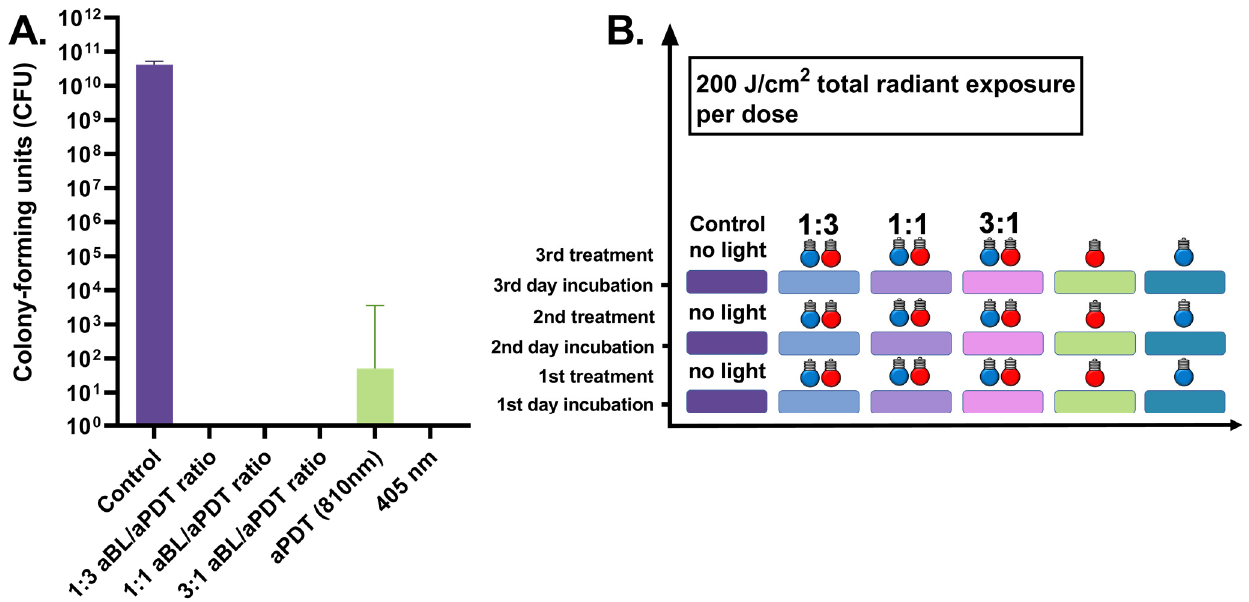
Figure 6. ( A ). Effects of different irradiance ratios of aBL and aPDT in the dual-light aPDT system in three-day S. aureus biofilm, when the antibacterial treatment is given once daily at 200 J/cm2. Three-day S. aureus biofilm, daily dose, aBL vs. dual-light 1:3 aBL/aPDT ratio, p = ns; aBL vs. dual-light 1:1 aBL/aPDT ratio, p = ns; aBL vs. dual-light 3:1 aBL/aPDT ratio, p = ns; aPDT vs. dual-light 1:3 aBL/aPDT ratio, p = ns; aPDT vs. dual-light 1:1 aBL/aPDT ratio, p = ns; aPDT vs. dual-light 3:1 aBL/aPDT ratio, p = ns; aBL vs. aPDT, p = ns; dual-light aPDT: 1:3 aBL/aPDT ratio vs. 1:1 aBL/aPDT ratio, p = ns; 1:3 aBL/aPDT ratio vs. 3:1 aBL/aPDT ratio, p = ns; 1:1 aBL/aPDT ratio vs. 3:1 aBL/aPDT ratio; p = ns. The y -axis displays the median of CFUs. Six assays were performed for each experiment, and the control biofilm was performed in three assays. The 95% confidence interval (CI) is presented by using t-bars; ns = non-significant. ( B ). A schematic representation of the experiment.